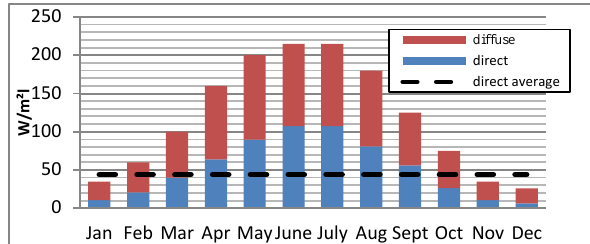
Figure 4: Monthly solar irradiance (direct/diffuse) together with the annual average serving as input data for (3) and (4) (source DWD, rf. Palz and Greif, 1996).